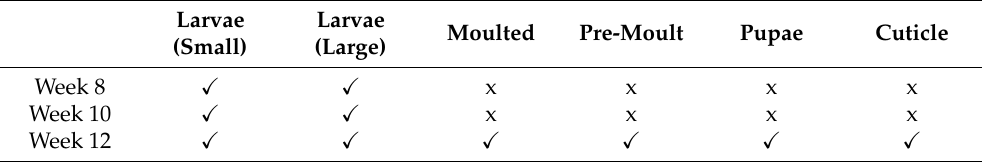
Table 2. Sample collection schedule of the different sizes and life stages of